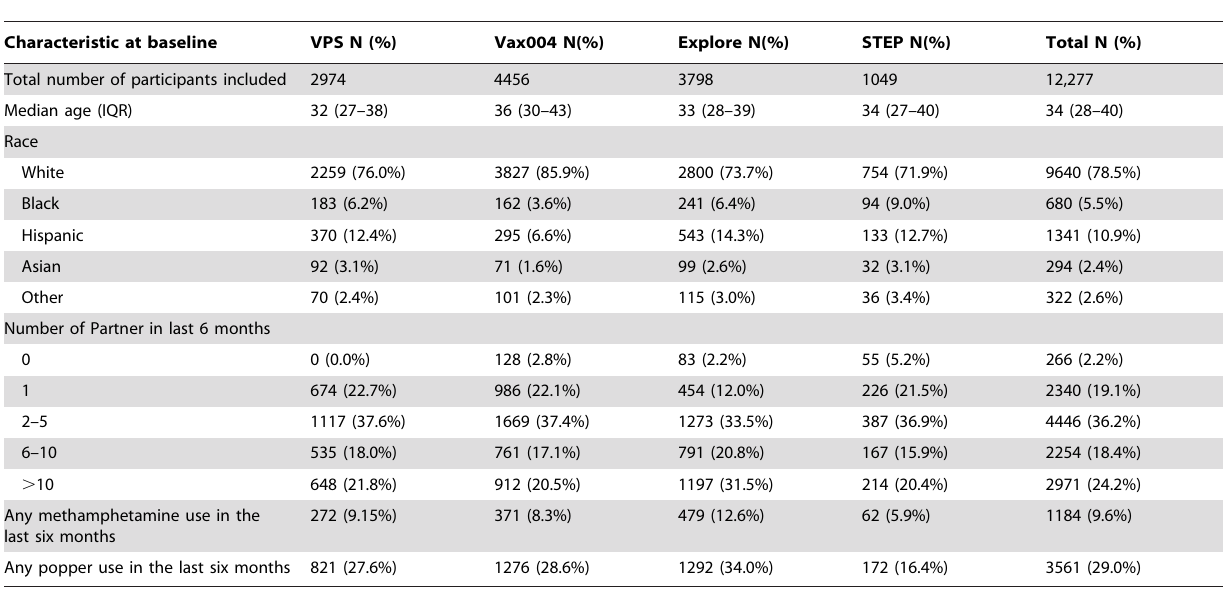
Table 1. Demographic and behavioral characteristics at baseline of North American men who have sex with men from four longitudinal cohort studies,